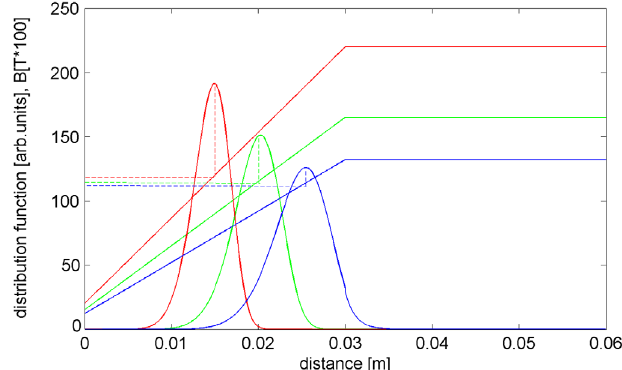
FIG. 12. Distribution of the stripping probability along the beam path (bell-shaped curves) inside a magnet with a linearly ramping fringe field (the magnetic field profile is shown on the same graph).